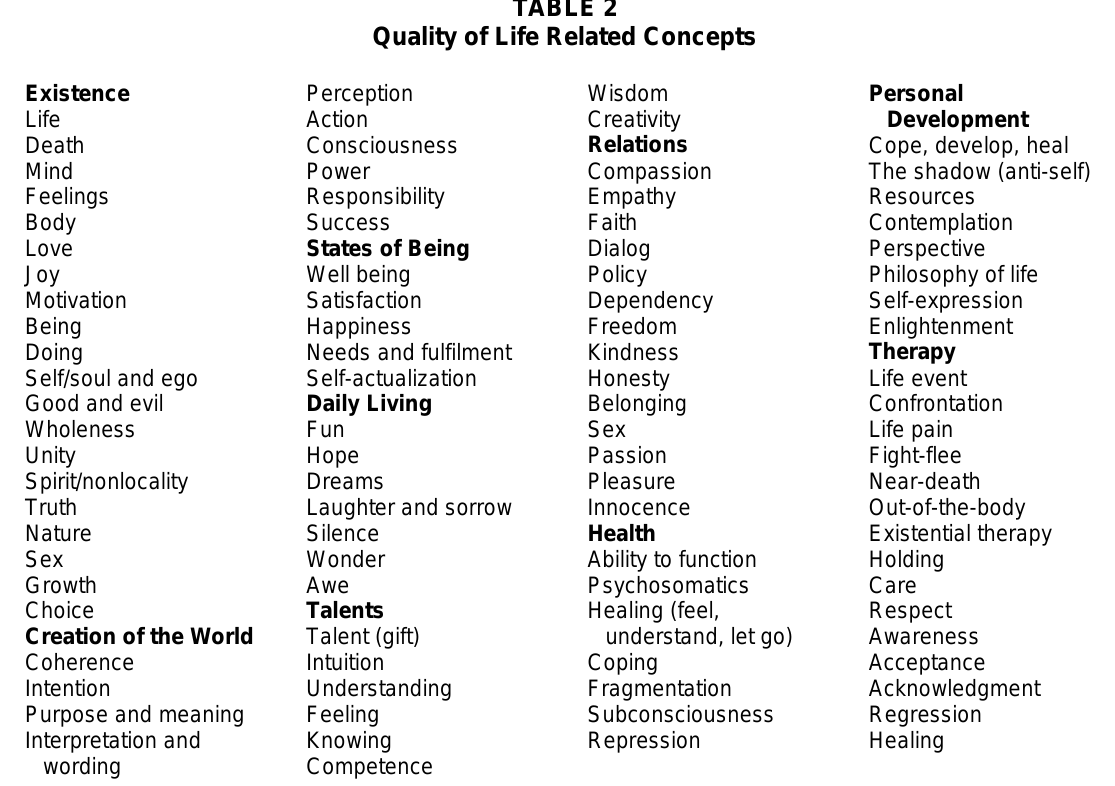
Quality of Life Related